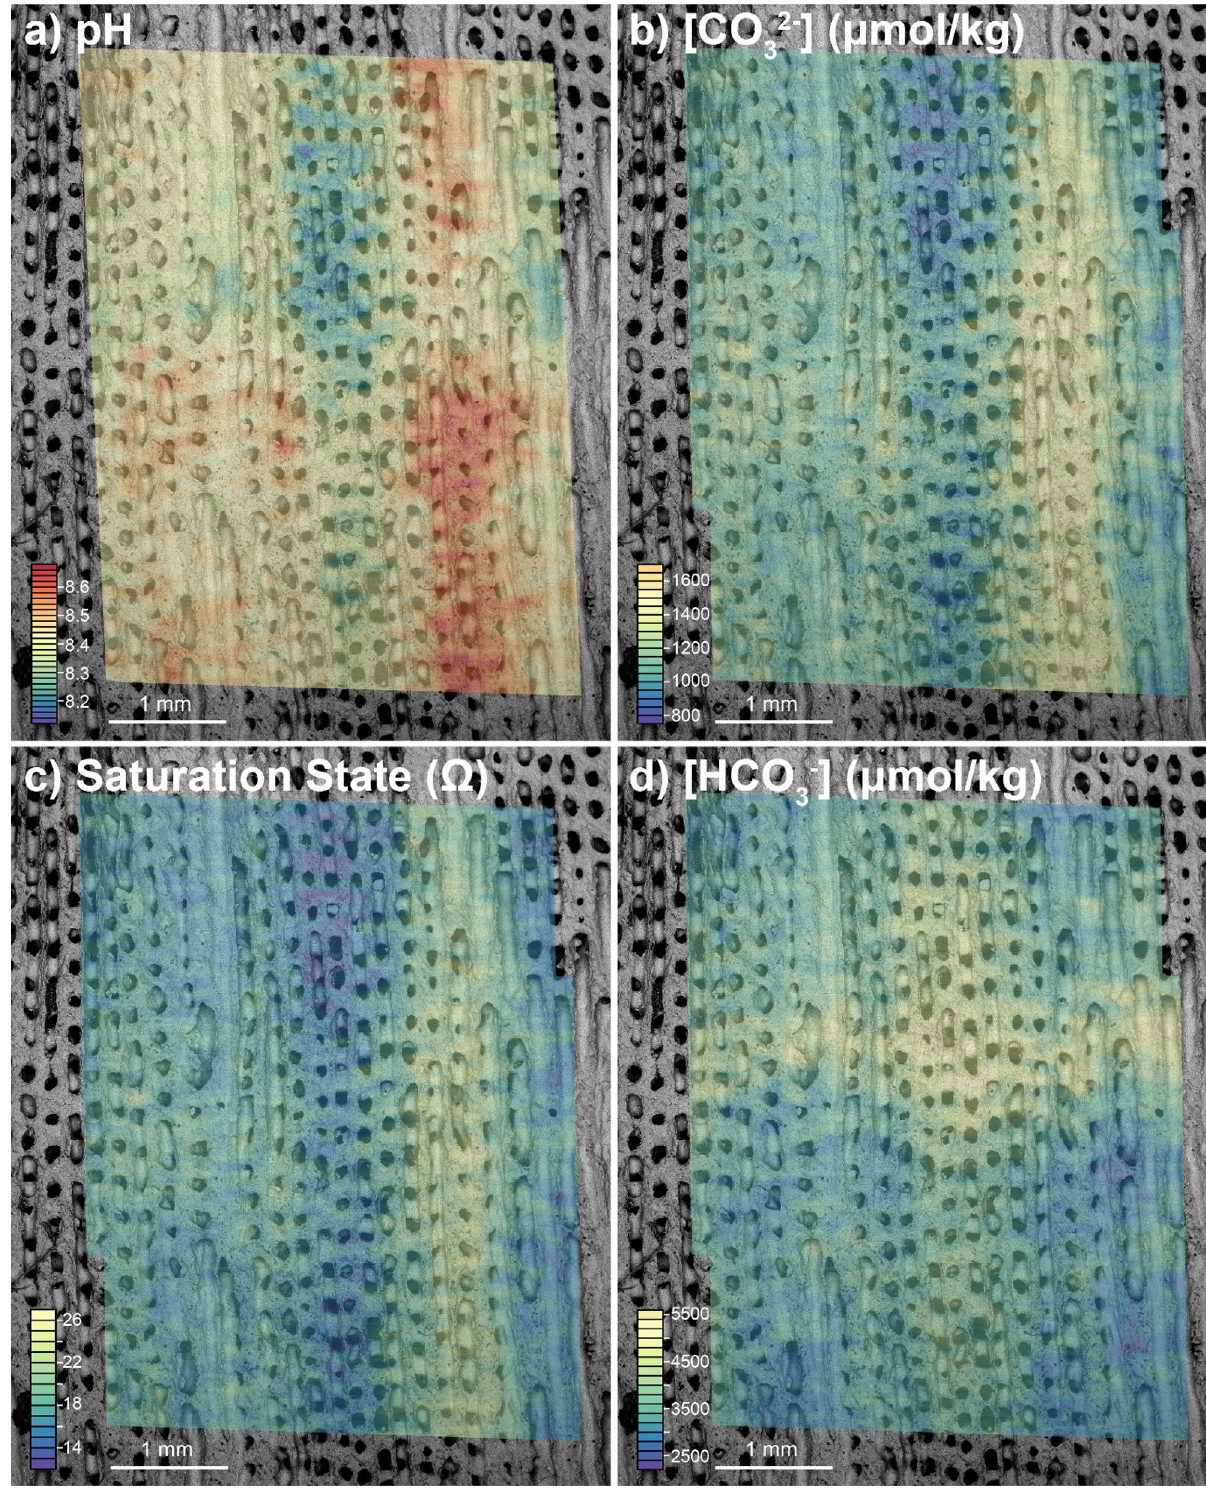
Figure 5. Four plots showing carbonate system parameters recovered from the calcifying fluid: ( a ) pH cf calculated from δ 11 B, as is clear from the raw data the pH is elevated in the wall compared to the columella, though both show an annual cycle and sub-annual features are visible within the walls; ( b ) carbonate ion [CO 32− ] cf calculated from δ 11 B and B/Ca, similar to pH cf , carbonate ion is elevated in the walls and shows an annual cycle; ( c ) aragonite saturation state calculated using δ 11 B and B/Ca data, as expected from pH cf and [CO 32− ] cf the saturation state is higher in the denser material of the walls, and tending towards seawater values at the centre of calcification; ( d ) bicarbonate (µmol/kg) calculated from δ 11 B and B/Ca. For further details see “Materials and methods”